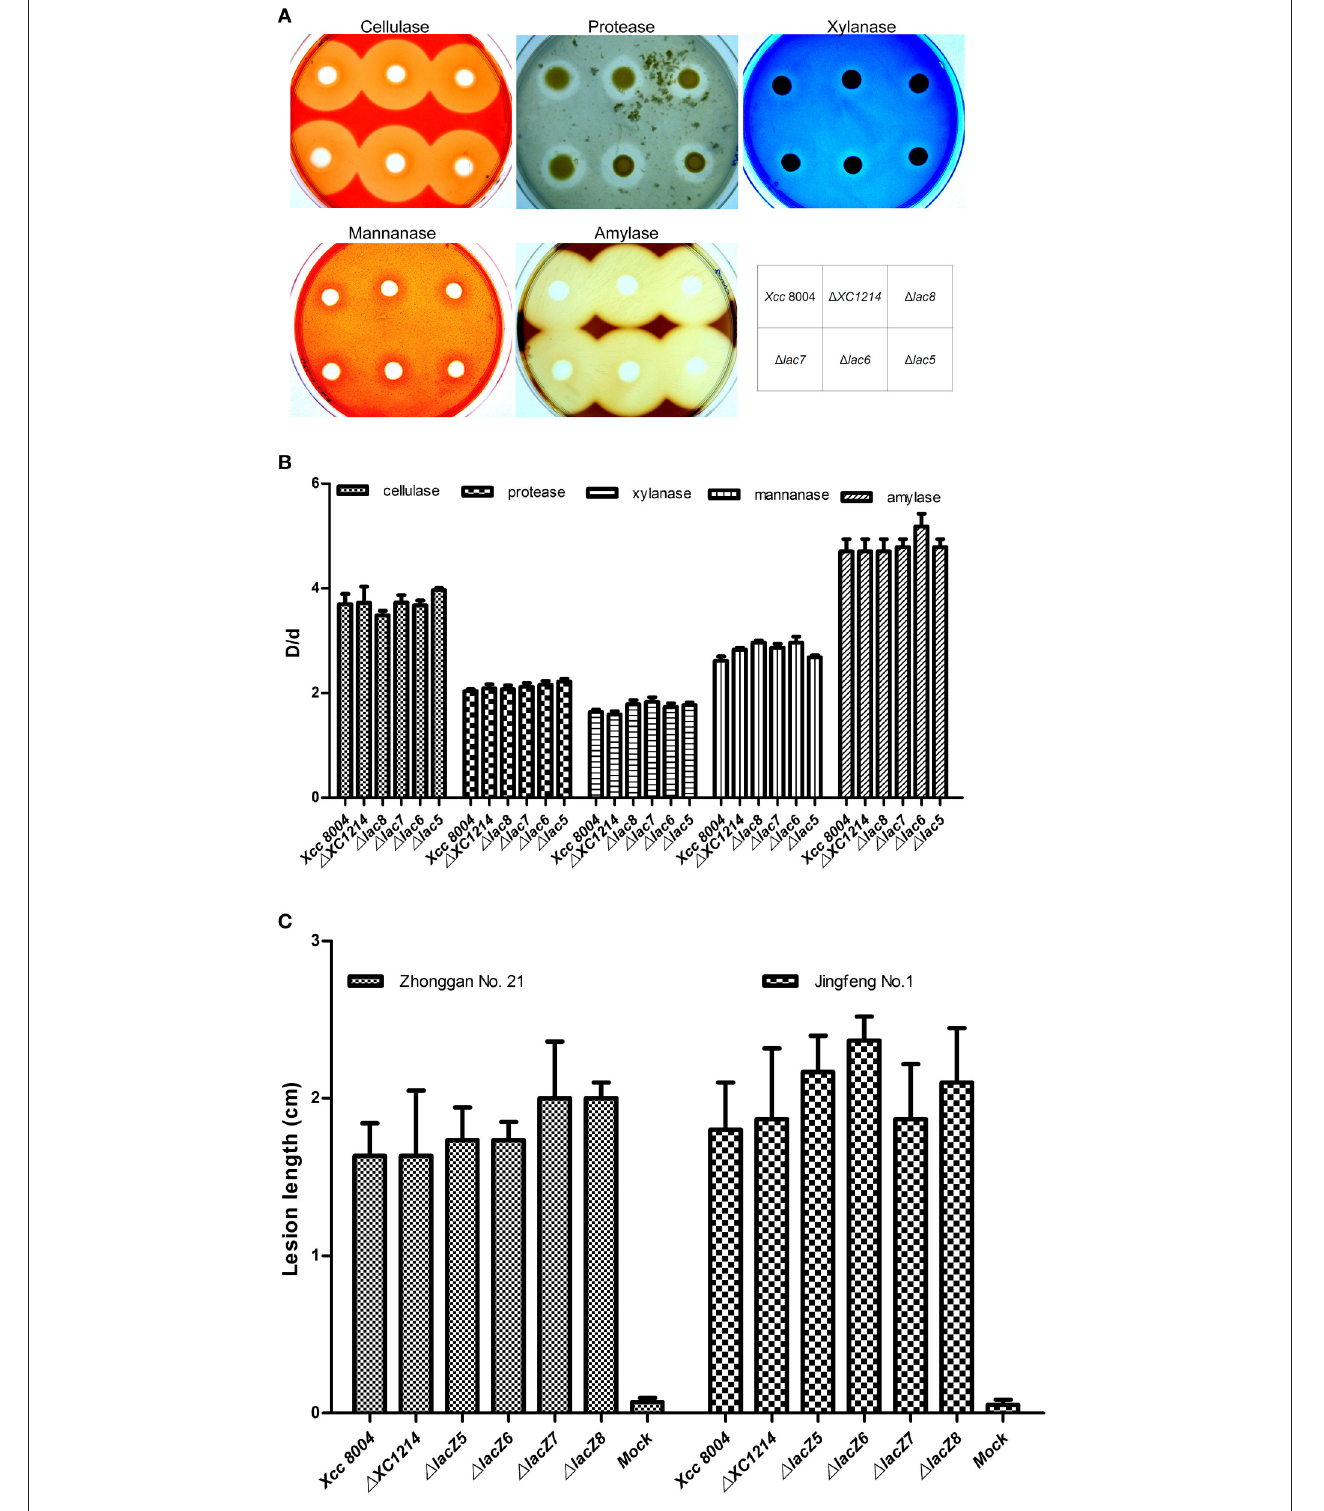
FIGURE 6 | Virulence-related analysis of the GH2 and GH35 mutants. (A,B) The extracellular enzyme activities of the GH2 and GH35 mutants. (C) The virulence of the GH2 and GH35 mutants on cabbage 9 days after inoculation. Jingfeng No. 1 and Zhonggan No. 21 are two species of Brassica oleracea . Virulence assays were performed on 12 leaves, and the means ± SDs were